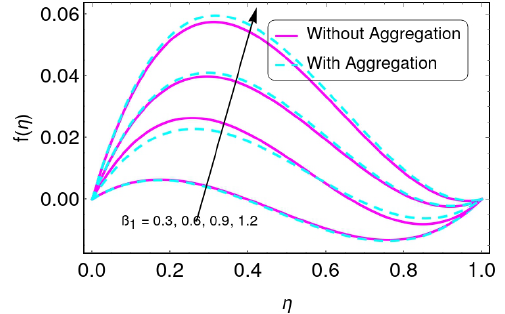
Figure 3. Characteristics of ß 1 for f ( η ) .